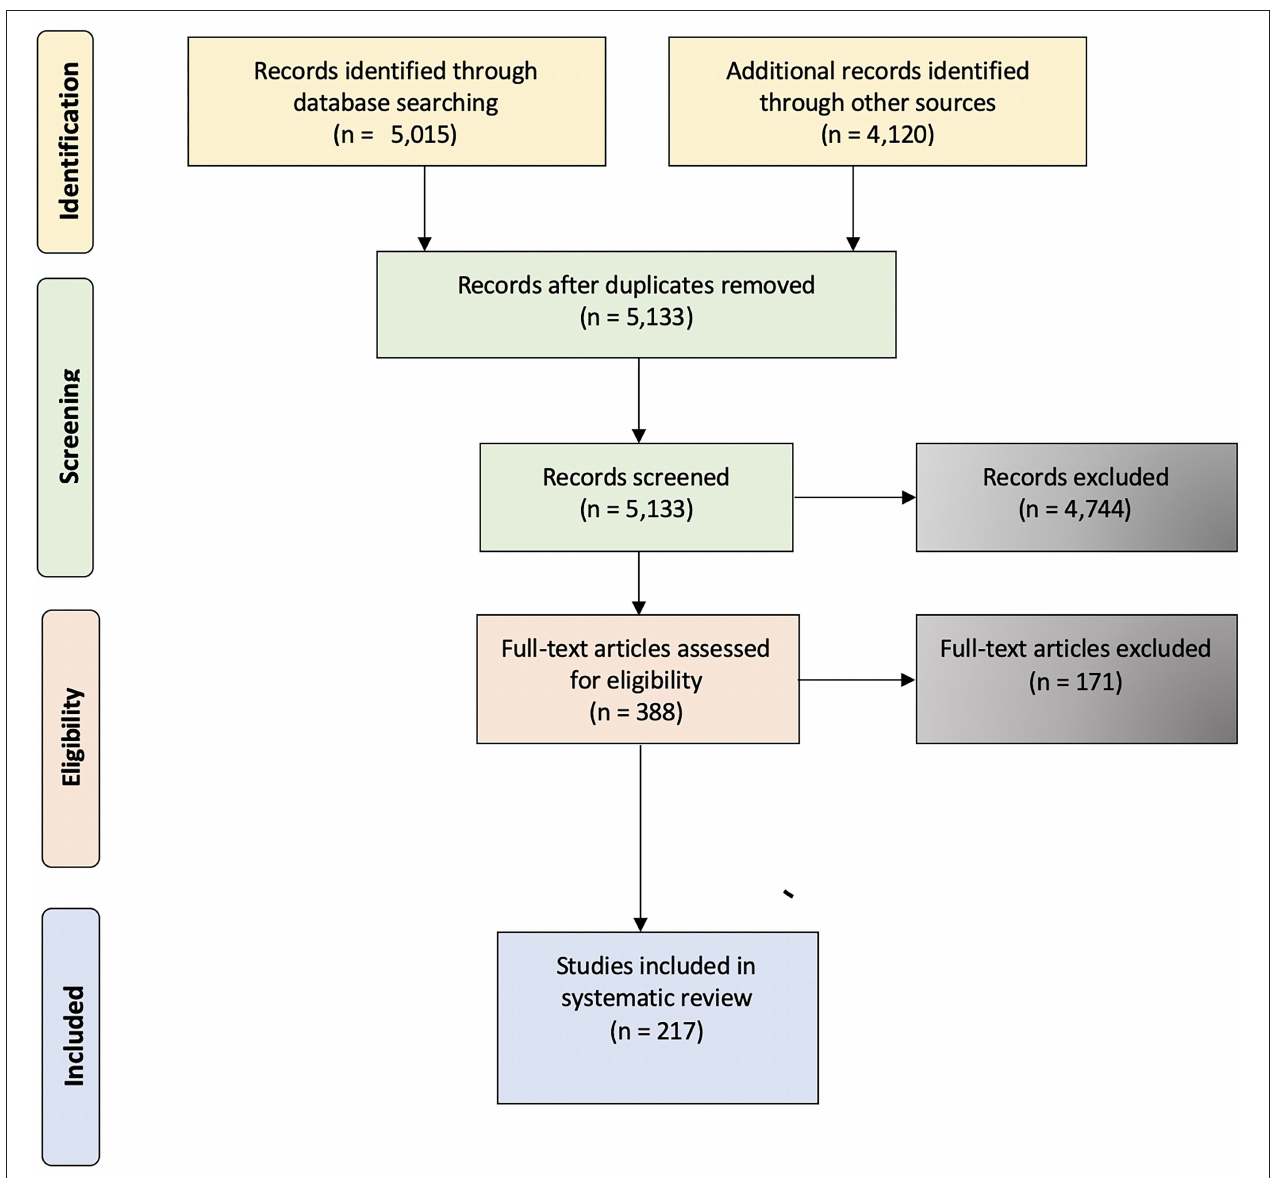
FIGURE 1 | Prisma flow